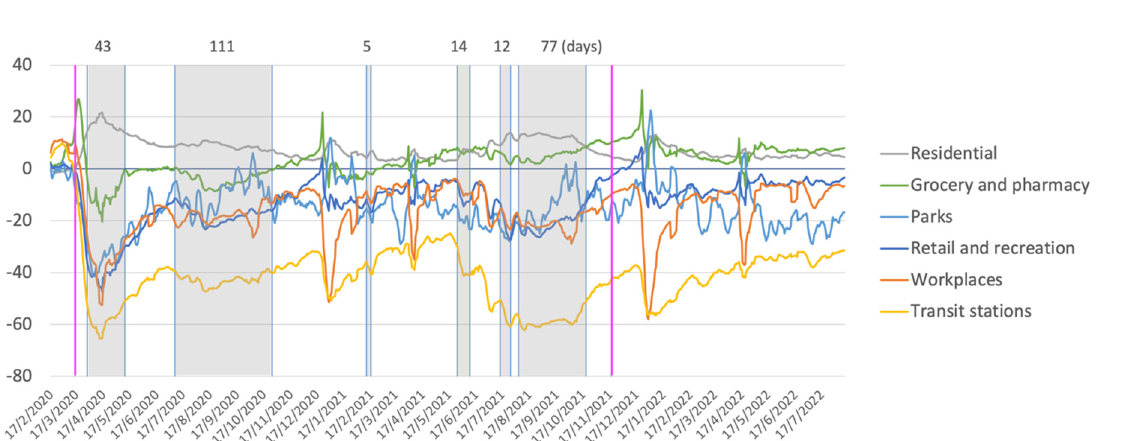
Table 1. Dates and duration of COVID-19 restrictions and lockdowns in Melbourne, Australia. Event